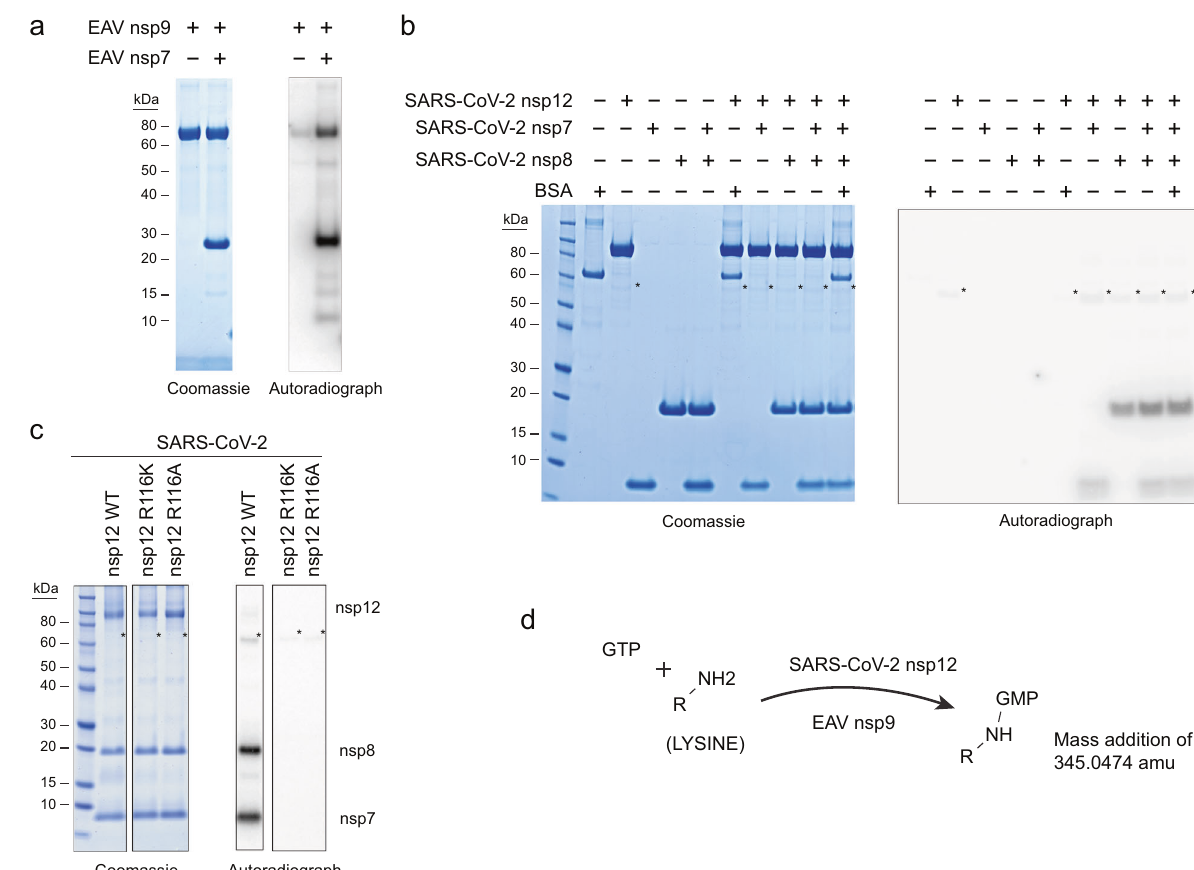
Fig. 1 SARS-CoV-2 and EAV RdRP proteins are radiolabeled by incubation with α - 32 P-GTP. a SDS-PAGE analysis of nucleotidylation reactions that contained EAV nsp9 with or without nsp7. b SDS-PAGE analysis of nucleotidylation reactions that contained SARS-CoV-2 nsp7, nsp8, and/or RdRP nsp12 combinations along with BSA as indicated. c SDS-PAGE analysis of nucleotidylation reactions that contained SARS-CoV-2 proteins nsp7 and nsp8 with nsp12 WT or indicated mutants. d Summary of general fi ndings observed in this study. Coomassie stained gels and autoradiographs are shown to visualize total protein or proteins that were radiolabeled, respectively. Asterisks indicate the location of a faint band observed in both the Coomassie stained gel and autoradiograph. Detection of nucleotidylation of EAV and SARS-CoV-2 proteins by radiolabeling were observed in three separate